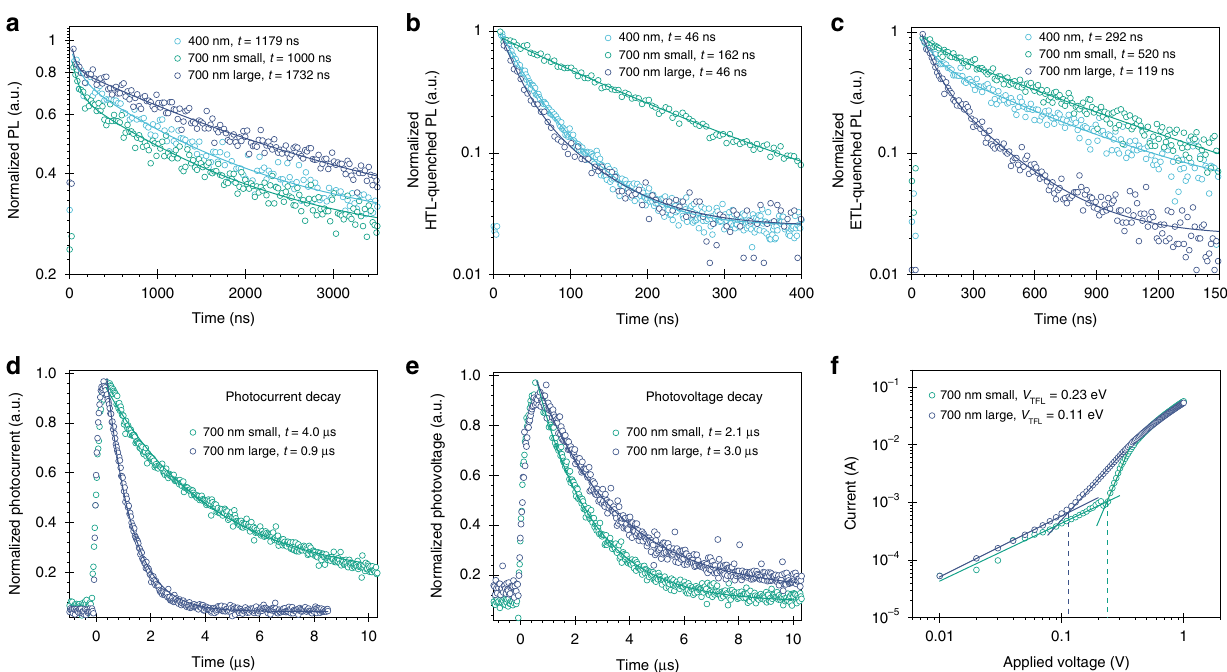
Fig. 4 Effects of grain size on carrier transport and trap density in thick perovskite. a Non-quenched, b spiro-OMeTAD, and c PCBM-quenched time- resolved photoluminescence spectroscopy measurements on perovskite fi lms. d Transient photocurrent, e photovoltage decay and f Space charge limited current of 700 nm perovskite devices with various grain (SCLC) measurement (Fig. 4f), in electron-only devices (ITO/ SnO 2 /Perovskite/PCBM/Ag), resulting in a V oc increase of 20